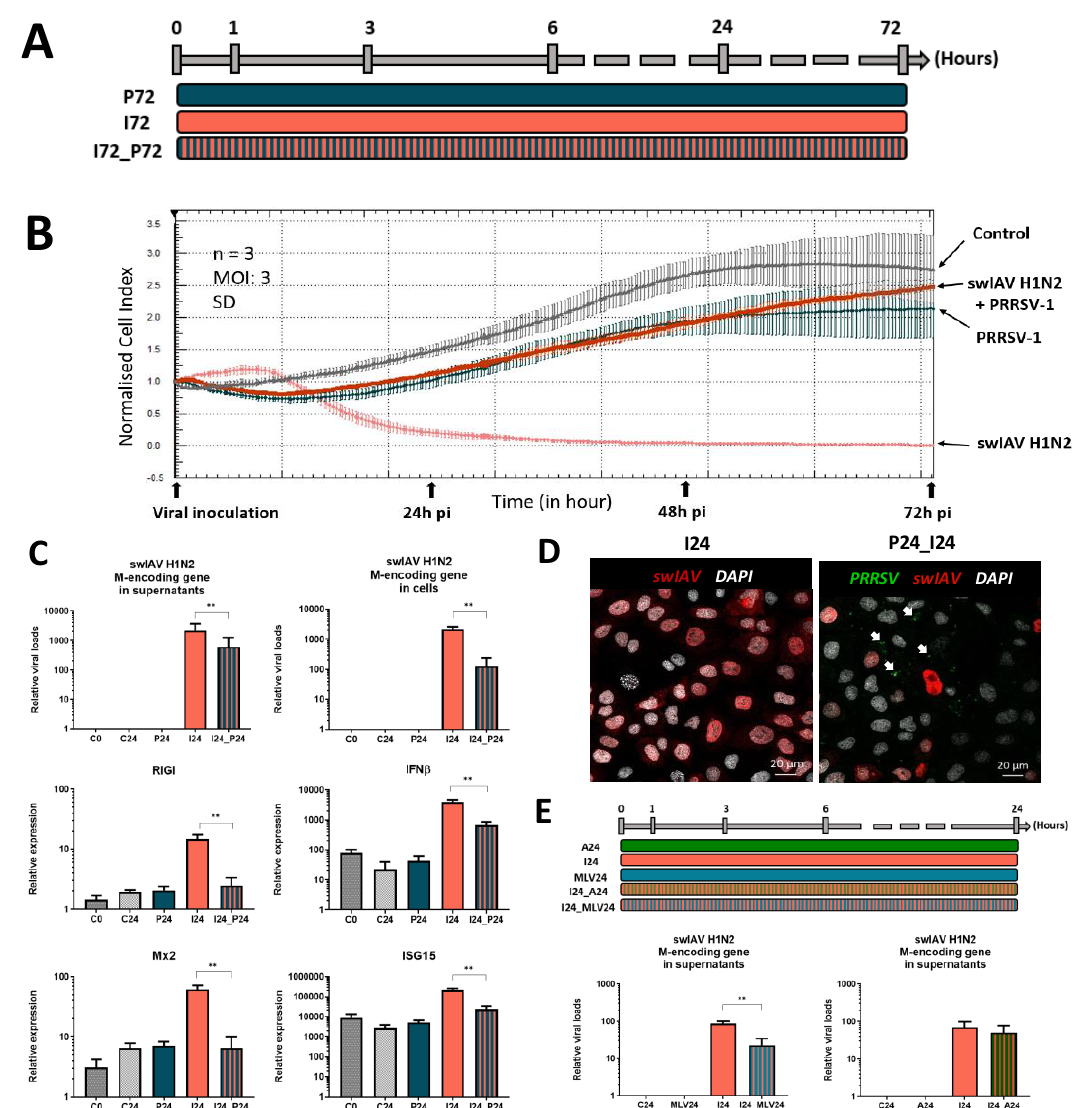
Figure 1. Protocol ( A ), normalized cell index ( B ), relative viral loads and relative expression of cellular transcripts ( C and E ), and immunostaining ( D ) of the different conditions in newborn pig tracheal cells showing the negative impact of PRRSV-1 on swIAV H1N2 replication and NPTr cells response. Cells were infected at a MOI of 3, n = 6 wells per condition for qPCR and n = 3 for the impedancemetry. Mean values and standard deviations are represented. C0 and C24 stand for the non-infected conditions over 0 h and 24 h respectively, P24 and P72 stand for PRRSV-1 stimulation over 24 h, and 72 h, I24, and I72 for swIAV H1N2 infection over 24 h and 72 h, A24 for ADV infection over 24 h, MLV24 for stimulation with the DV strain of PRRSV-1 over 24 h, I24_P24, I24_A24, I24_MLV24, and I72_P72 for the coincubation of 2 viruses over 24 h or 72 h. Comparisons were carried out using a one-way ANOVA test and Tukey’s post-test. Di ff erences were considered significant when p < 0.05 (*) or p < 0.01 (**). NPTr cells ( D ) were fixed after 24 h and stained with an antibody against viral N protein to detect PRRSV-1 particles and PRRSV-1 infected cells (in green—white arrows) and an anti-nucleoprotein polyclonal antibody to detect swIAV H1N2 particles and infected cells (in red). Cell nuclei were stained (in white) using 4′,6′-diamidino-2-phenylindole (DAPI). Images were generated using a laser-scanning confocal microscope.